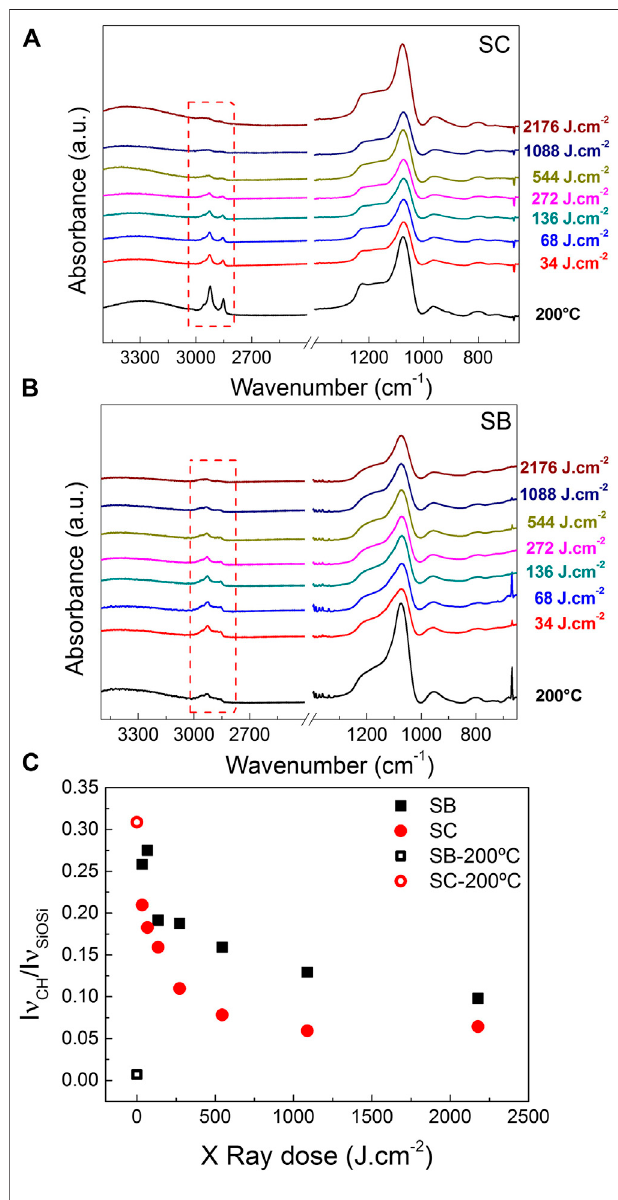
FIGURE 1 | FTIR spectra of (A) SC and (B) SB fi lms irradiated with different XR doses. Films prepared with the same sols but consolidated with a thermal treatment at 200 ° C are also shown. Bands corresponding to the surfactants are marked with red dash lines. (C) Ratio of ν C-H and ν Si-O-Si FTIR bands intensities for both systems, as a function of the XR dose. Results for samples treated at 200 ° C are also presented, as indicated in the labels.